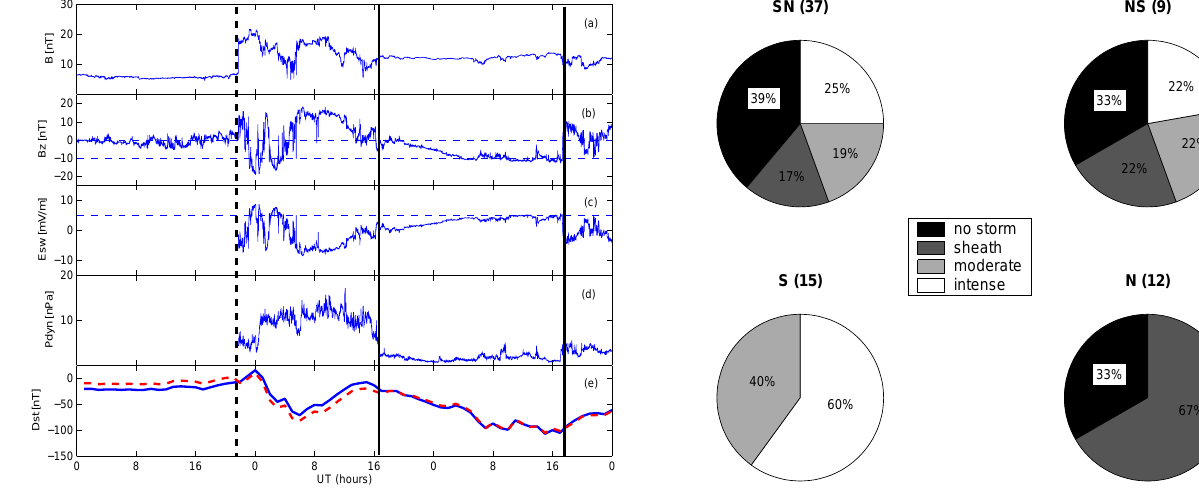
Fig. 13. Solar wind parameters and geomagnetic indices for a 3-day interval from 12–14 October 2000 measured by ACE. The figures from top to bottom are the same as in Fig. 9.